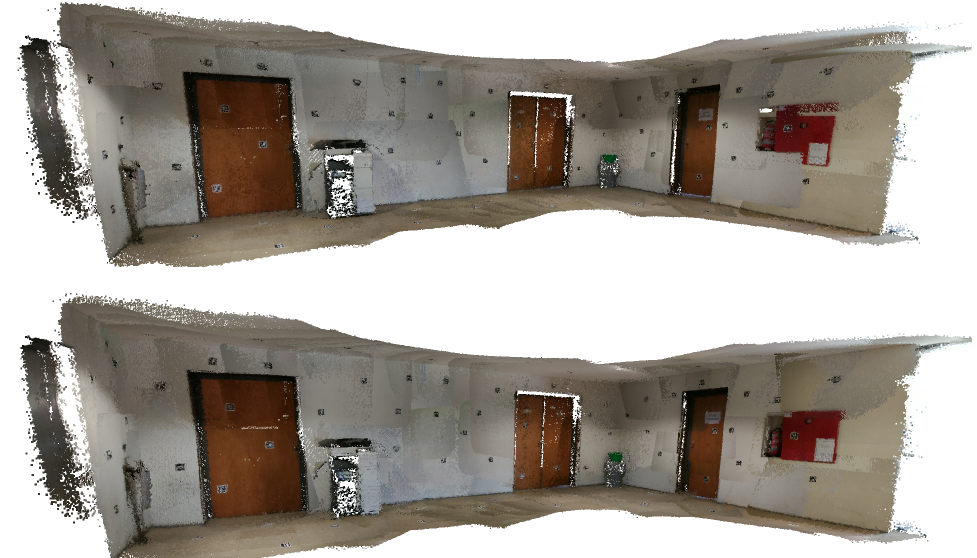
Figure 25. Lobby dataset coloured with texture obtained from original images: ( top ) Google Tango; ( bottom ) Our approach.